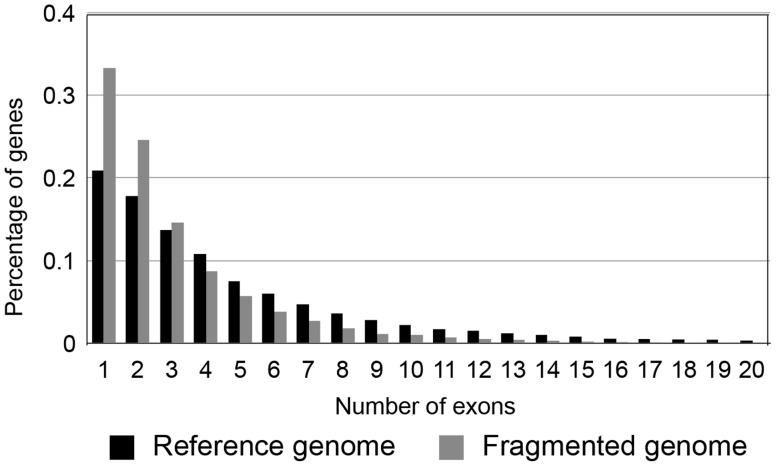
Number of predicted exons per gene decreases with increased genome fragmentation.A comparison of the number of predicted exons per gene in the uncut D. melanogaster reference genome to the fragmented version of this genome that contains 17,941 contigs (the right-most point in Fig. 4). Gene models were predicted using GENSCAN.